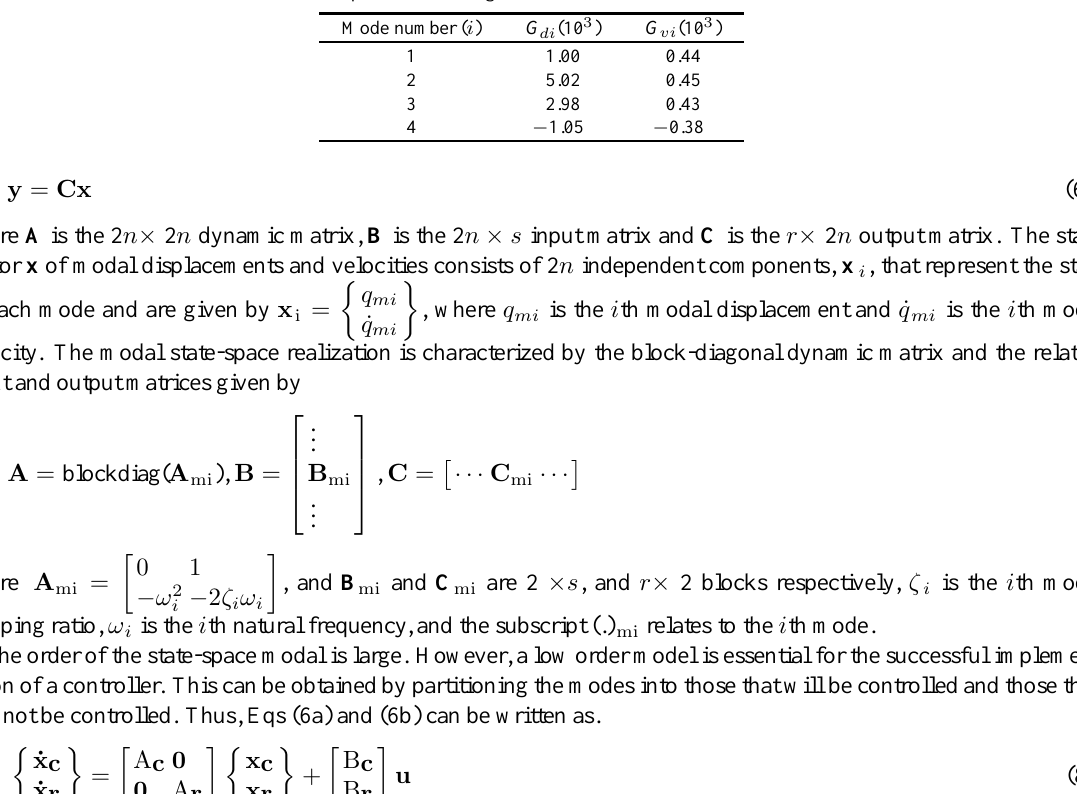
Table 2 Optimal feedback gains for the controlled